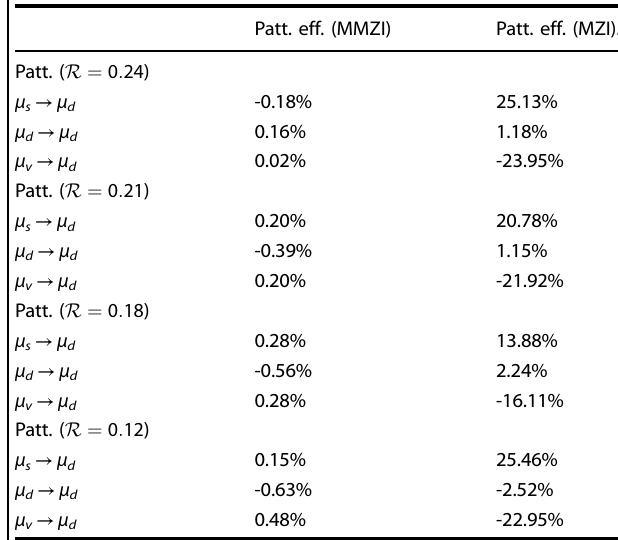
Table 2. Comparing the MZI and MMZI. Patt. eff. (MMZI) Patt. eff. (MZI).